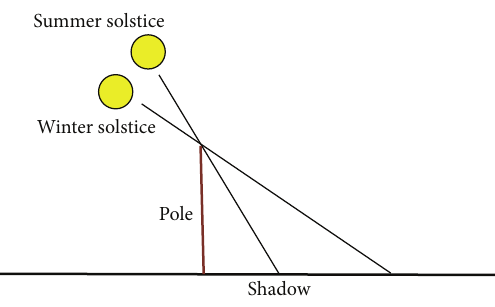
Figure 3: Yin-Yang daylight model [3].